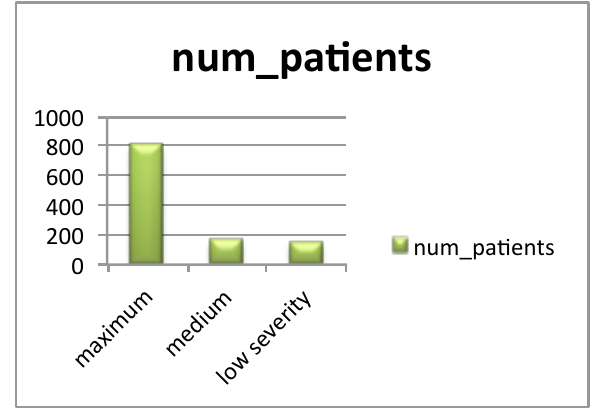
Fig. 1. Number of patients for each event severity level (maximum, medium, low).